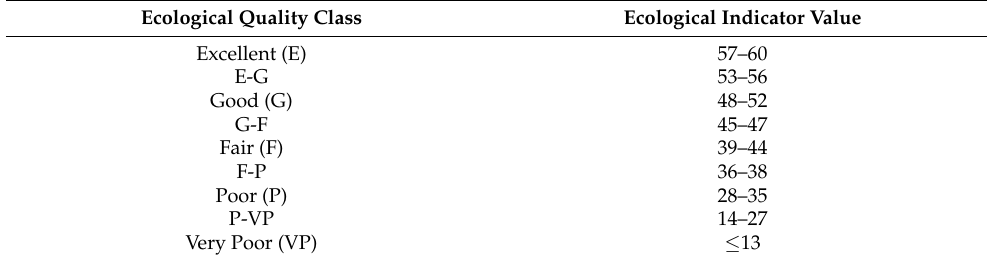
Table 3. IBI values corresponding to each class of biotic